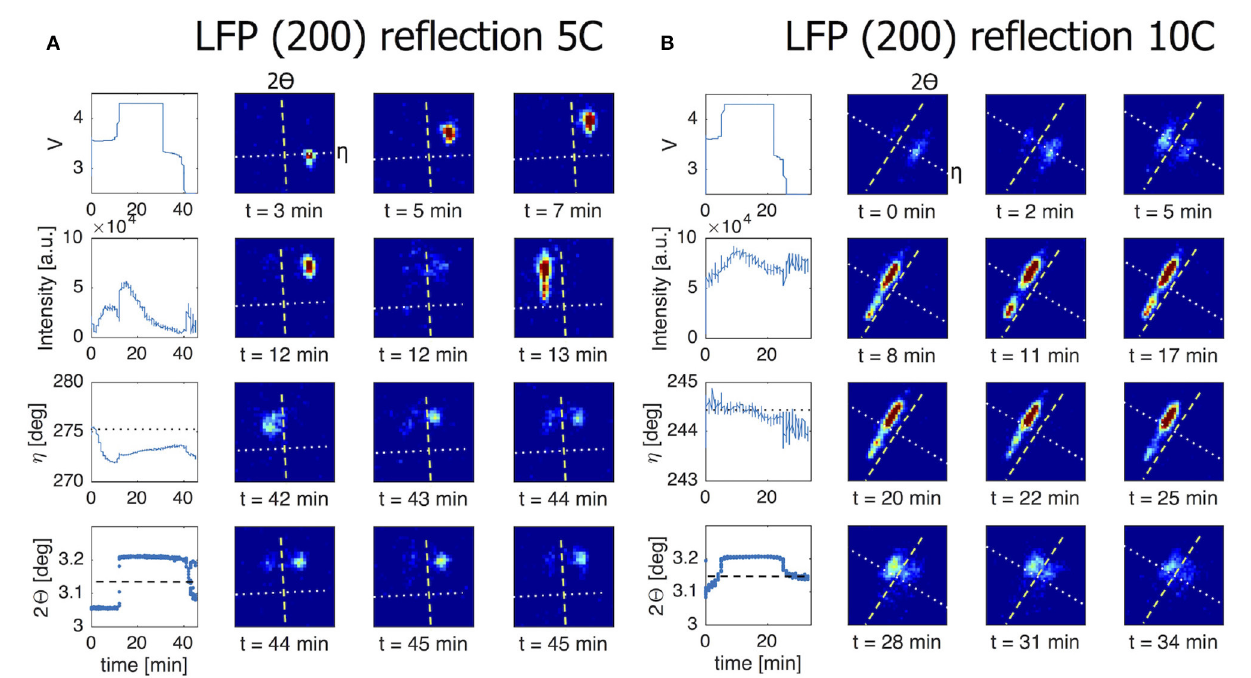
FIGURE 6 | The line charts in the left most column of both figures show from top to bottom the voltage of the battery, the intensity of the grain reflection, the change in the η angle and the change in the 2 2 angle for this particular grain reflection. All for a 5C/10C charge/discharge cycle. The dotted line in the η graph corresponds to the dotted line shown in the 2D plots. The dashed line in the 2 2 graph corresponds to the dashed line in the 2D plots. (A) The (200) reflection in this 5C experiment shows significant η movement at the beginning of charge. This continues until LFP-FP phase transition takes place without phase coexistence and within 2 min. During the transition back from FP to LFP the a-lattice is changing in a homogeneous way although a part of the crystallite remains in the FP phase. The observed decrease in integrated intensity during the upper voltage hold is likely caused by the grain rotating out of Bragg condition. Since this reflection is seen around the equator ( η = 90 or η = 270) a rotation along the z-axis will remove the Bragg condition. (B) In a 10C experiment we are following a (200) reflection. At t = 5 min there is clear phase coexistence during the LFP-FP phase transition. At the FP-LFP phase transition the intensity is spread and this grain remains inhomogeneous for the a-lattice well after discharging has